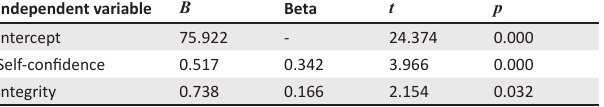
TABLE 4: Results of multiple regressions with psychological capital scale score as a dependent variable and subscales of authentic leadership as independent variables.